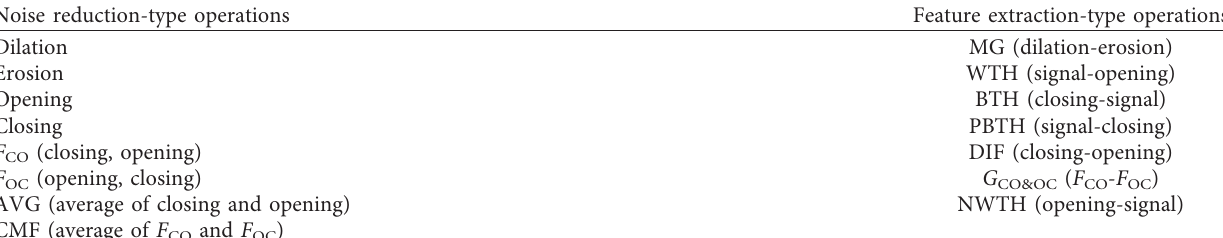
Table 1: Classification of the morphology